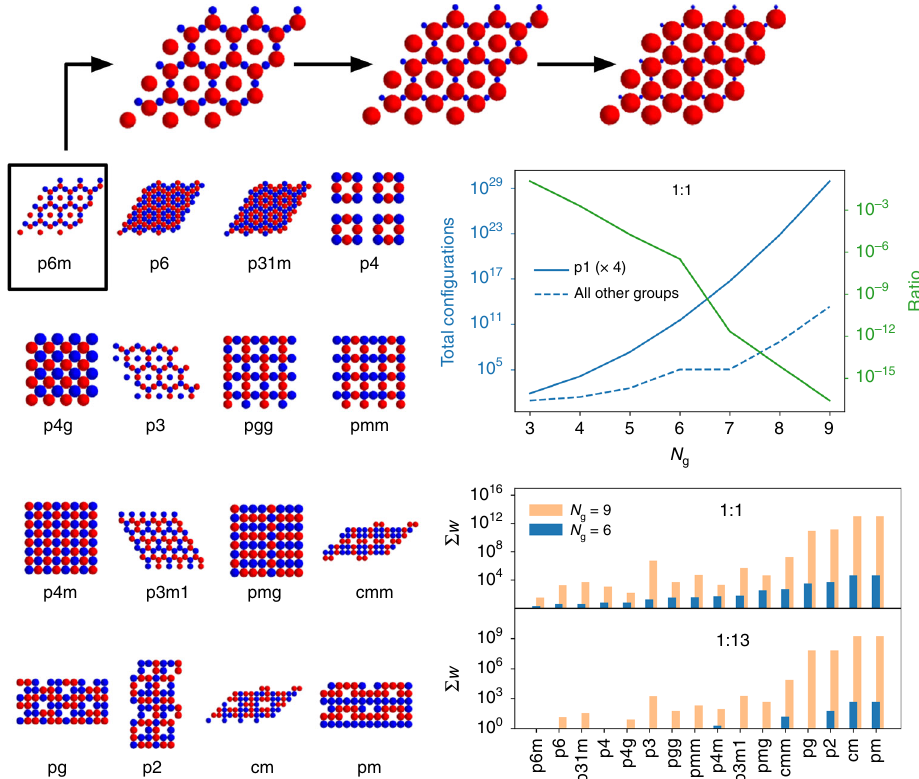
Fig. 2 Enumeration of solutions to the constraint satisfaction problem (CSP). The total number of con fi gurations, representing the sum of all realizations of all solutions to the CSP for all of the wallpaper groups besides p1, is given by the dashed blue line for a 1:1 binary mixture at various N g . When not constrained by the symmetry of a given group, we set the sides of its fundamental domain equal to each other and α = π /2. The solid blue line is the number of solutions for a total of 4 different p1 cells, each with different angles in their fundamental domain; the green line is the ratio between the two blue ones. Randomly chosen con fi gurations for each group are also depicted which have been scaled to contact for equally sized colloids. A breakdown of the number of solutions each group contributes is also provided for representative N g values and stoichiometries. Above, the p6m group ’ s solution has been scaled to contact assuming different diameters for the red colloids to illustrate how the same pattern can be used for differently sized